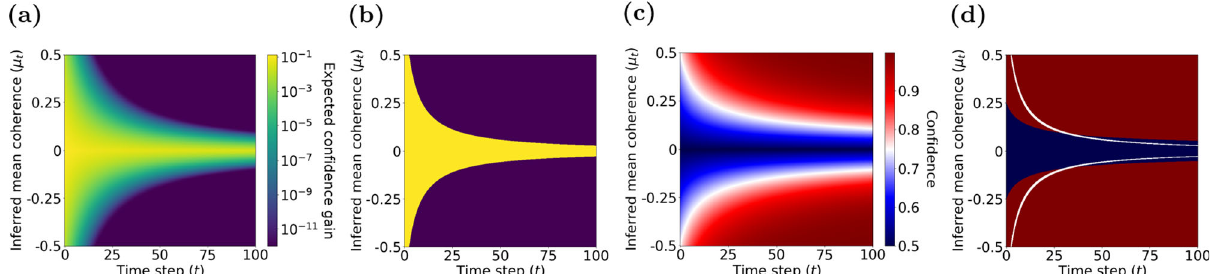
Fig. 3 Computation of choice and con fi dence in the POMDP model of the direction discrimination task. a The expected con fi dence gain for a new observation as a function of inferred mean coherence, μ t , and elapsed time, t . b An example POMDP decision policy when new observations are associated with a constant cost. The yellow area represents the belief states where the optimal action is to continue observing. The purple area represents the belief states where the POMDP model terminates and commits to a choice. c Con fi dence as a function of inferred mean coherence, μ t , and time, t . d The ratio of reward utilities for sure-bet and correct direction choices determines the POMDP policy for choosing the sure-bet option. The policy for sure-bet can be illustrated as phase boundaries in the con fi dence plot of c . The blue region denotes combinations of inferred coherence and time for which the model would choose the sure-bet target. The red region denotes ( μ t , t ) for which direction targets are chosen. Thresholds for separating low and high con fi dence ratings are thus the boundaries between blue (low con fi dence) and red (high con fi dence) regions. Solid white lines show the two decision termination bounds where the model stops gathering more observations and commits to a decision. In these simulations σ z = 2.0, σ 0 = 1.0, and the utility ratio = 0.63.